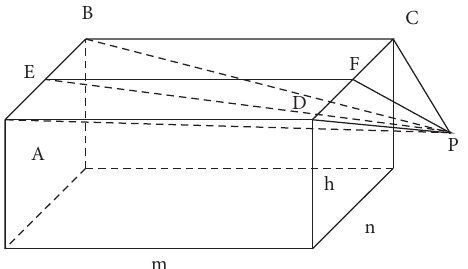
Figure 5: Point P is located outside, in the backdoor of the